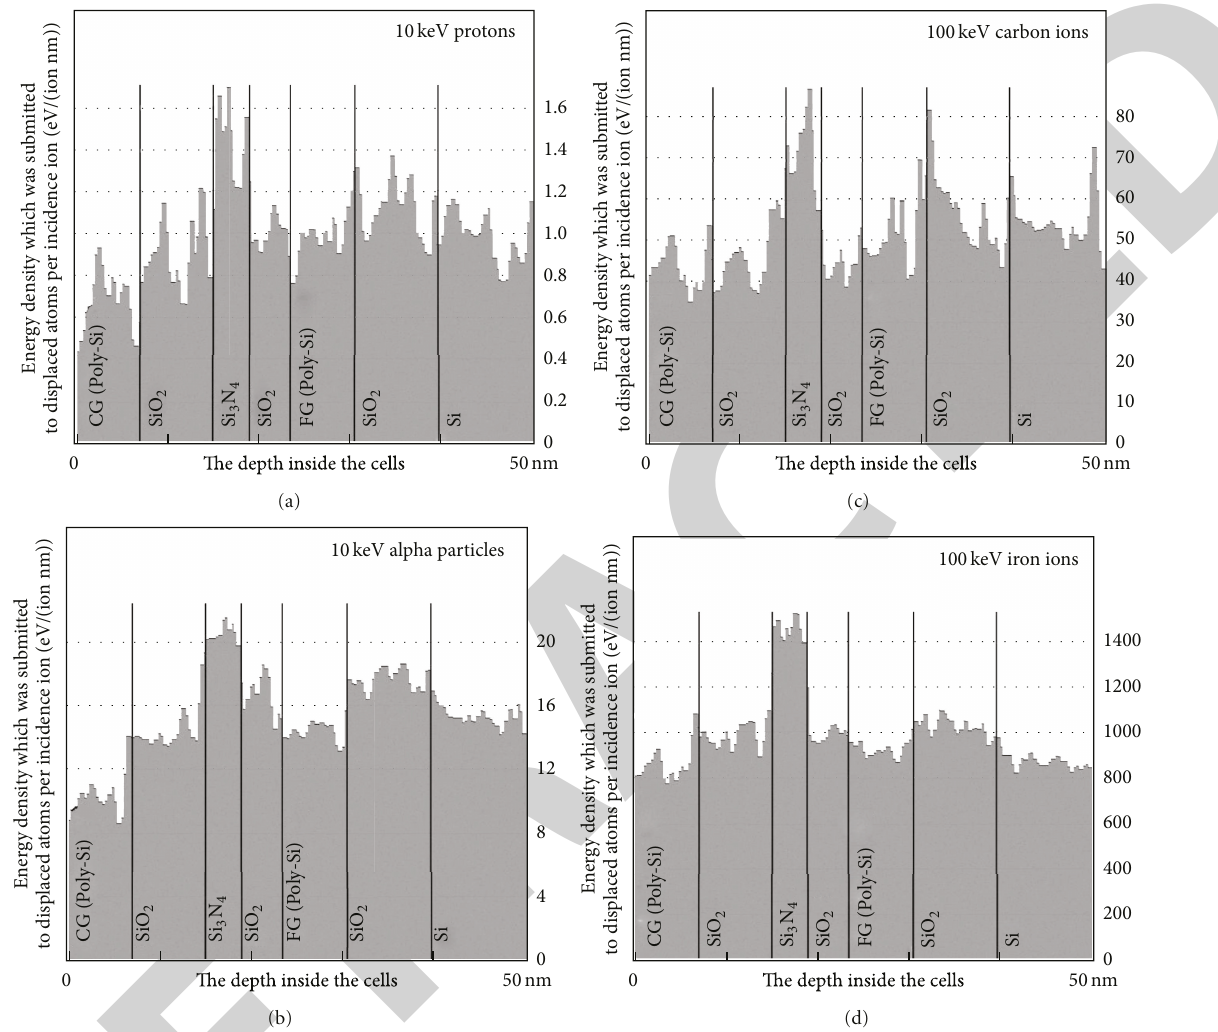
Figure 7: Density of ion energy (per unit of depth), which was submitted to atoms displaced in the layers of the flash cell (expressed per incident ion) for (a) 10keV protons, (b) 10keV 𝛼 particles, (c) 100keV ions of C, and (d) 100keV ions of